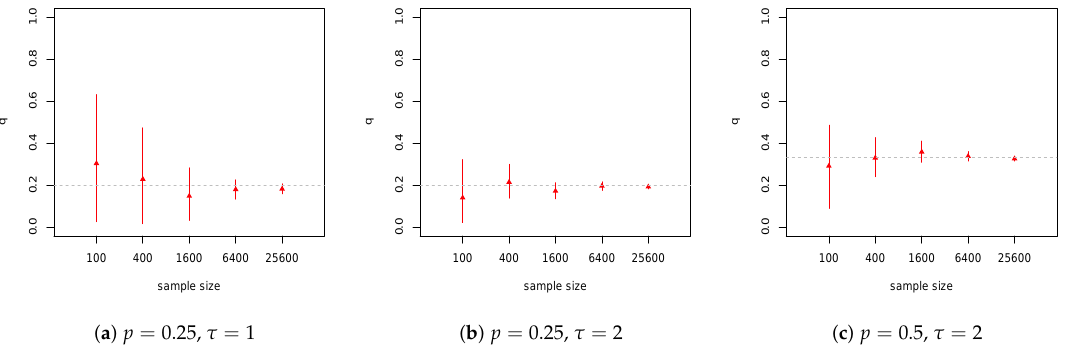
Figure 2. Credible intervals for the prevalence of misrepresentation q for the Weibull loss severity